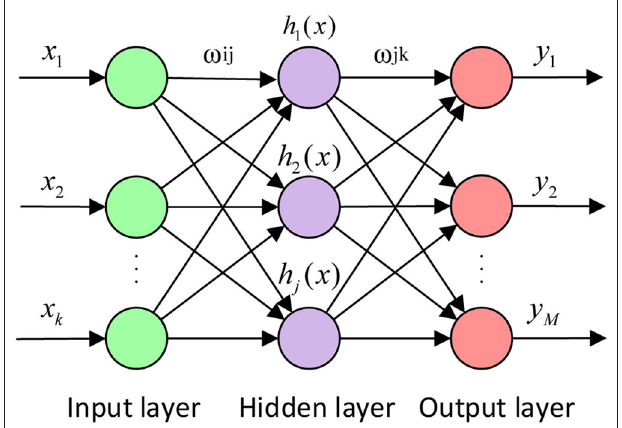
FIGURE 1 | The topological structure of wavelet neural